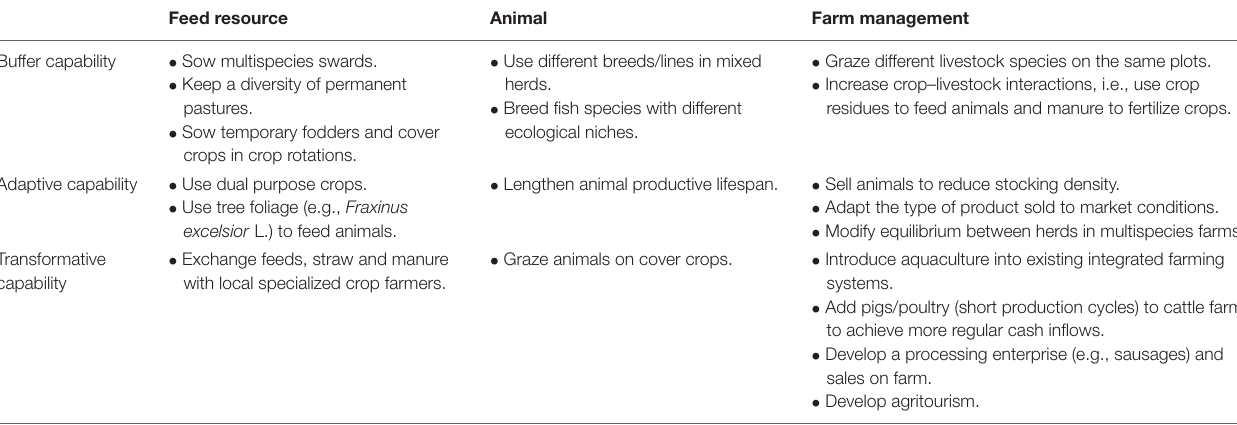
TABLE 1 | A typology of resilience factors [according to Darnhofer (2014)] related to on-farm diversity with examples. Feed resource